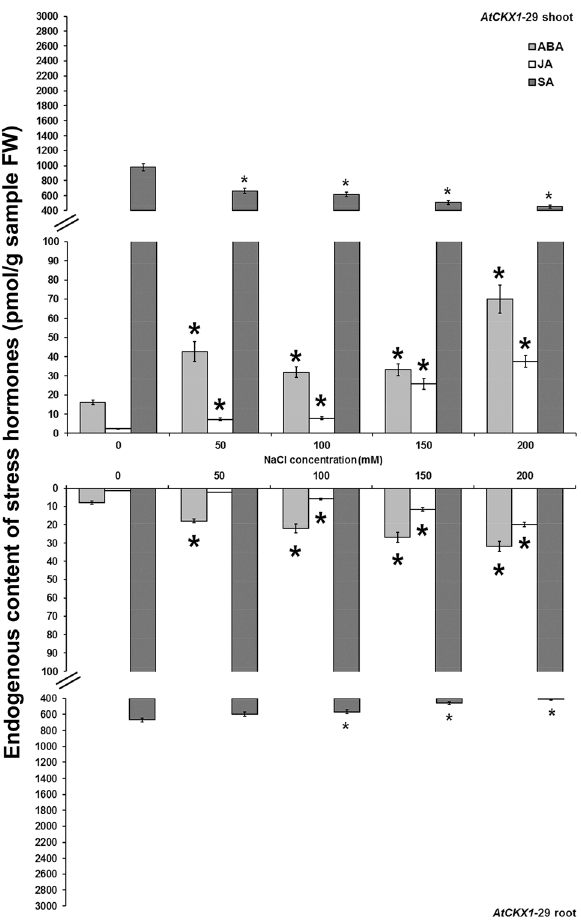
Figure 7. Endogenous ABA, JA and SA contents and in shoots and roots of 8-week-old AtCKX1 -29 transgenic Centaurium erythraea line. Data represent mean ± standard error. Means marked with asterisks are significantly different from corresponding control values (LSD test, p ≤ 0.05). The bigger asterisks represent the values significantly higher than control ones while smaller asterisks represent values significantly lower than control